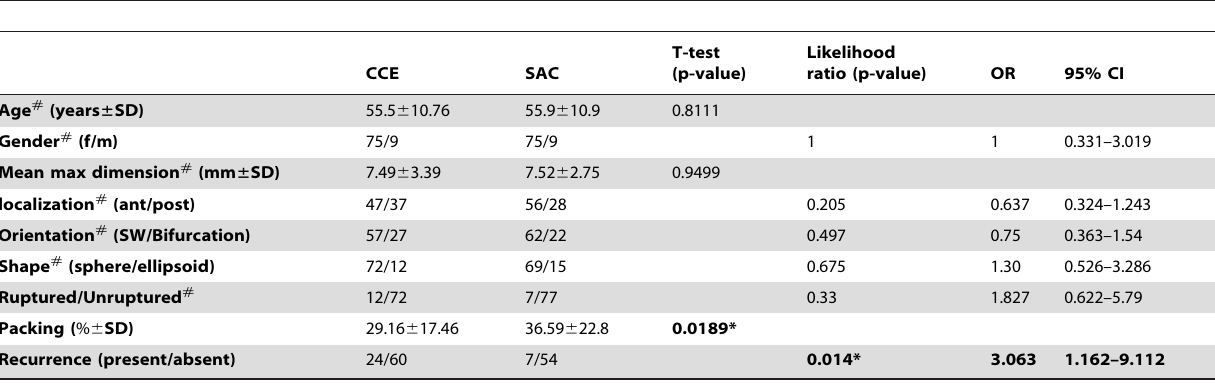
Table 5. Baseline Demographics of aneurysms treated by stent-assisted coiling and a matched group of aneurysms treated by conventional coil